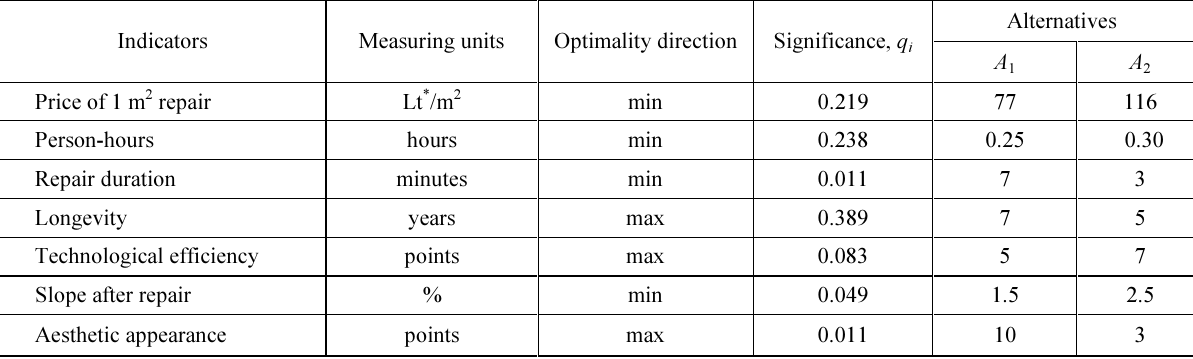
Table 1. Initial decision making matrix